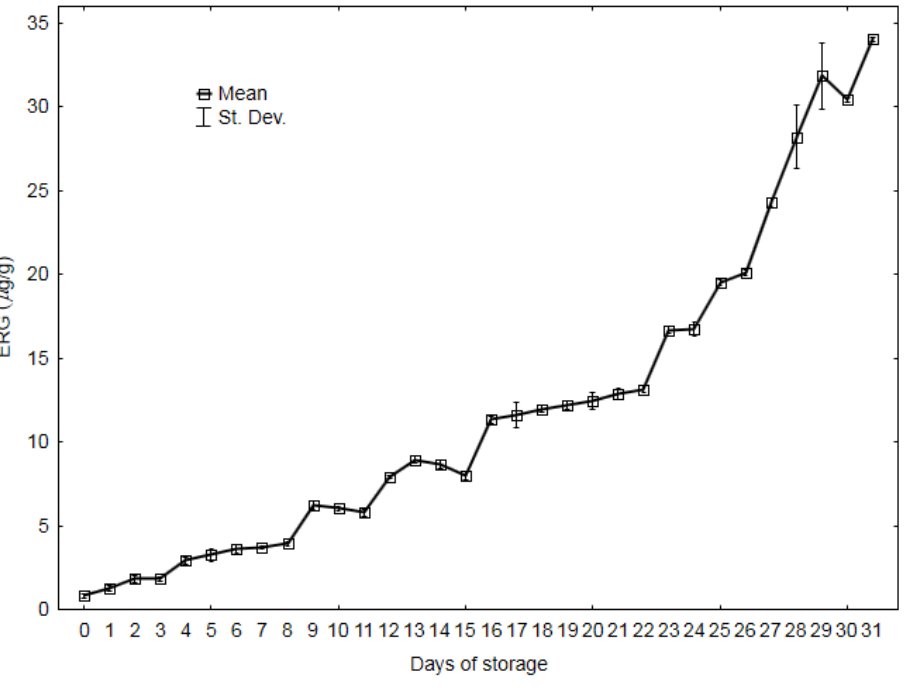
Figure 1. Ergosterol content (ERG) in rapeseed during 31 days of storage.